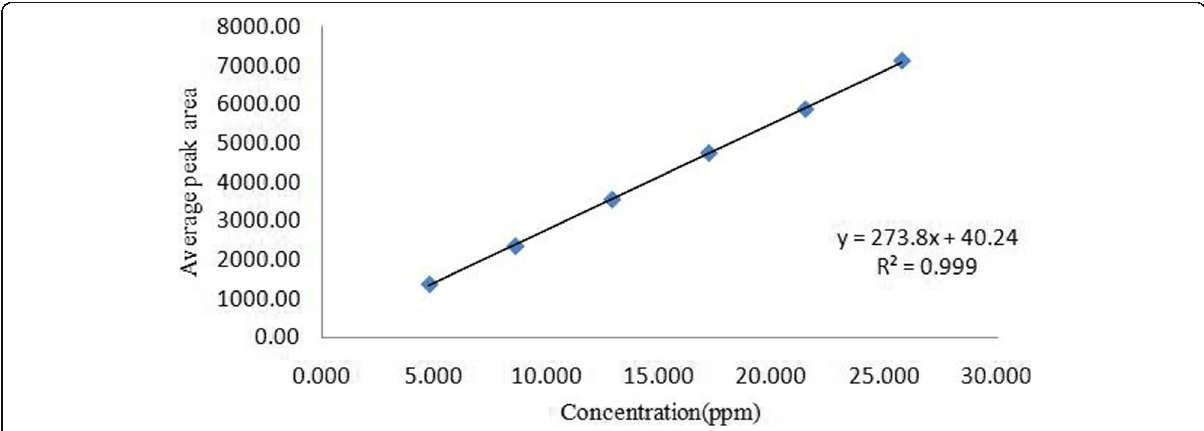
Fig. 4 Linearity curve of phenyl vinyl